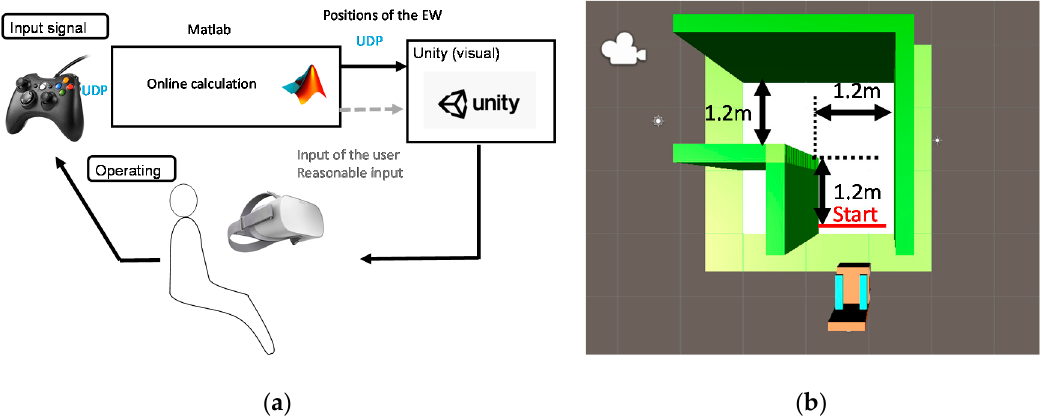
Figure 11. ( a ) Experimental setup and ( b ) experimental scene.